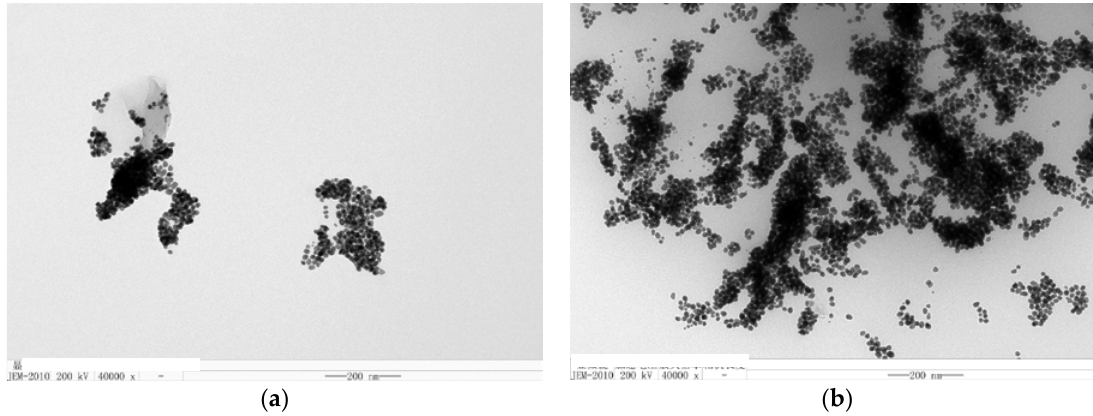
Figure 3. Transmission electron microscopy (TEM) of the analytical system. ( a ) 4.2 μM HAuCl 4 + 0.33 μM VBB + 0.33 mg/L C 60 + 170 μM TSC + 53 M BaCl 2 ; ( b ) a + 1.67 μM Na 2 SO 4 .